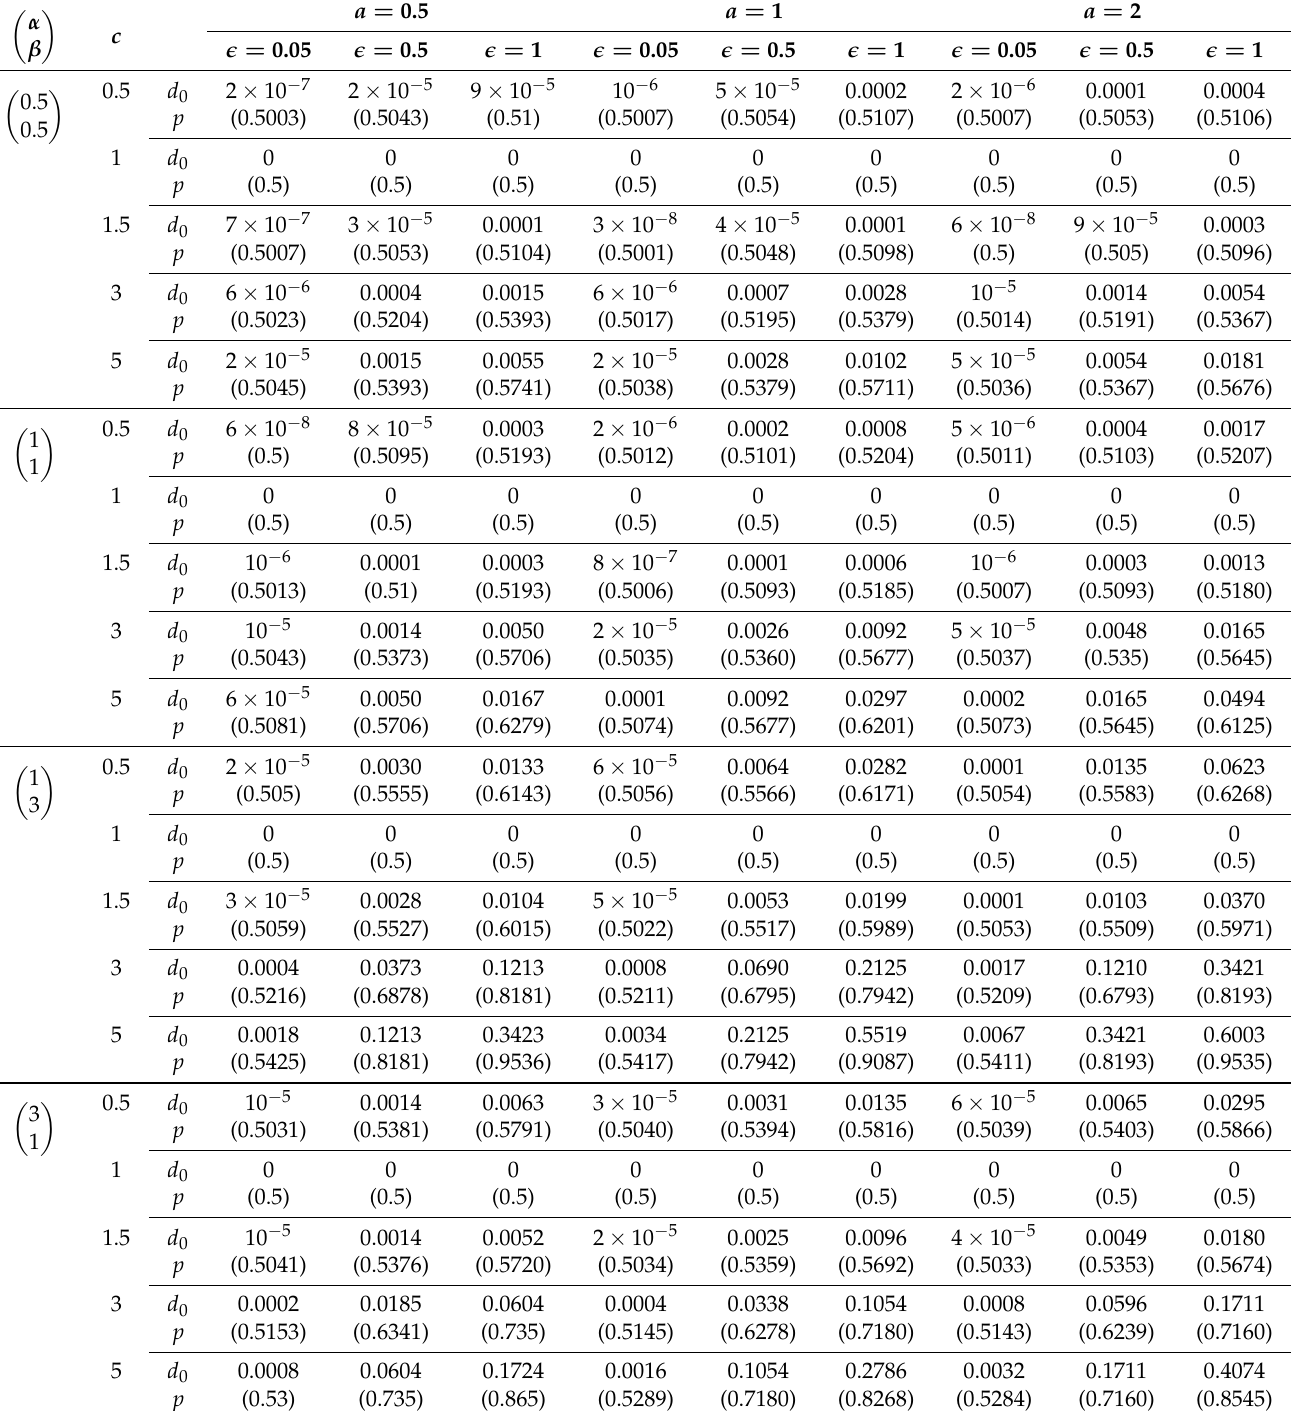
Table 3. Values of d 0 and p in (6) (for a (cid:54) = 1) and (7) (for a = 1) under class (2) for a sample generated from